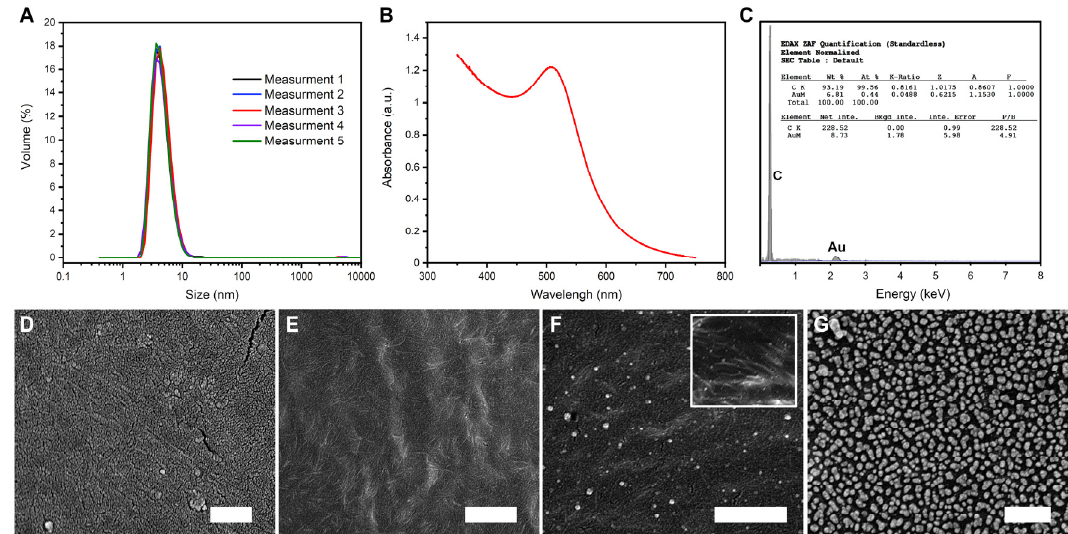
Figure 1. ( A ) DLS measurements show the hydrodynamic diameter of the initial AuNPs equal to 4.5 ± 1 nm. ( B ) UV-Vis measurement of the initial AuNPs. ( C ) EDX spectrum of BOA deposited onto the polypropylene surface, proving gold presence within the coating. SEM pictures of ( D ) pristine polypropylene vial used in the study; ( E ) pristine vial after 24 h incubation with M13 phages. Visible fiber-like features are virions. ( F ) The inner surface of the vial after single deposition of BOA, and ( G ) triple deposition of BOA. The inset in ( C ) shows the same surface as the main picture in ( C ), but without an additional thin layer of gold-sputtered to facilitate SEM observations. Scale bars correspond to 500 nm.